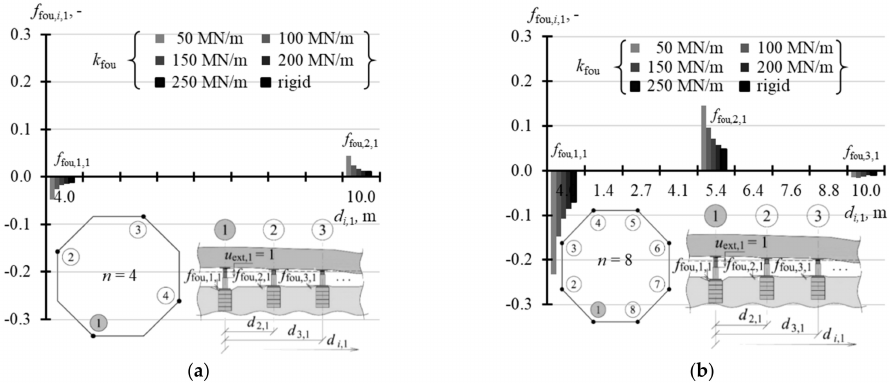
Figure 21. Elements of the matrix f fou of support displacements for different stiffness values k fou of the jack support: ( a ) n = 4; ( b ) n = 8.